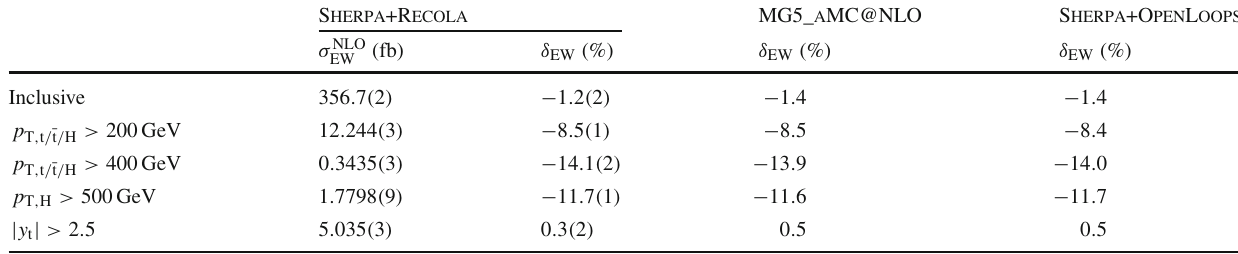
Fig. 14 Distributions of the di-muon and four-lepton invariant mass in the process pp → μ + μ − e + e − . Results are given for LO, NLO QCD, NLO QCD + EW and NLO QCD × EW Table 13 Integrated cross sections for pp → t ¯ tH at NLO EW for the set-up of Ref. [68]. The cross sections are expressed in fb, while the √ s = 13TeV calculated with Sherpa relativecorrectionsaregiveninpercent.Theintegrationerrorsofthelast a centre-of-mass energy of digits are provided in parentheses for the Sherpa + Recola predictions + Recola , MadGraph5_aMC@NLO , and Sherpa +O pen L oops for Sherpa + Recola